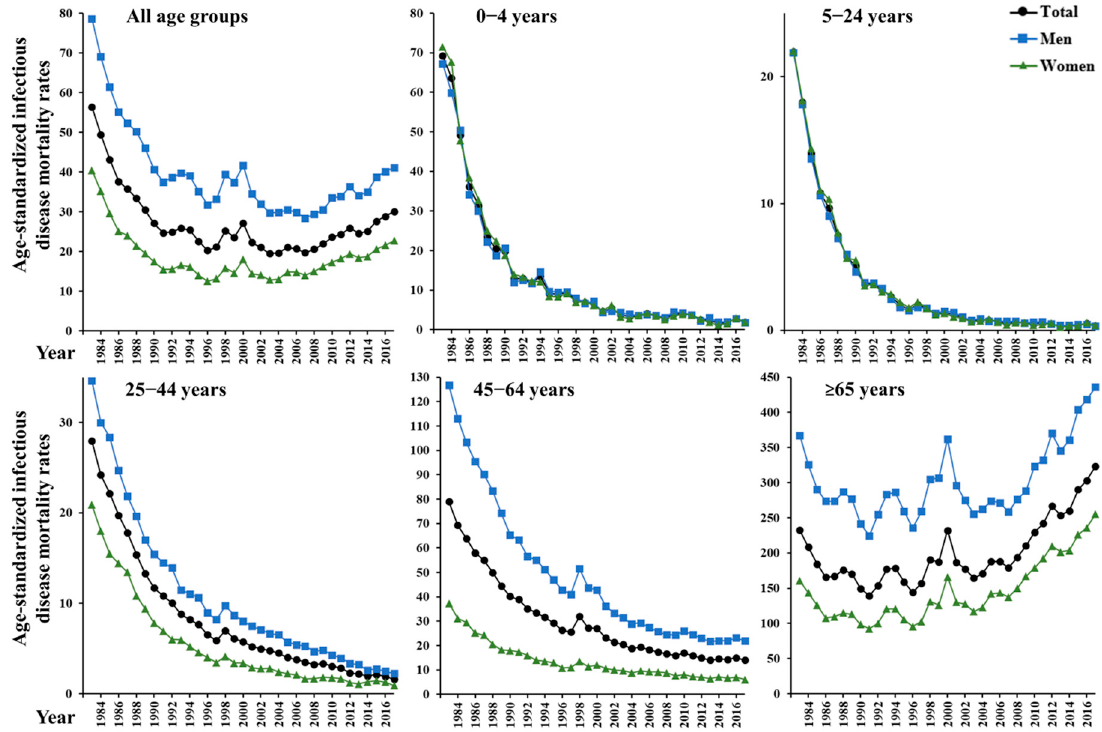
Figure 1. Trends in age-standardized mortality rates from infectious diseases by sex and age group (all age groups, 0–4